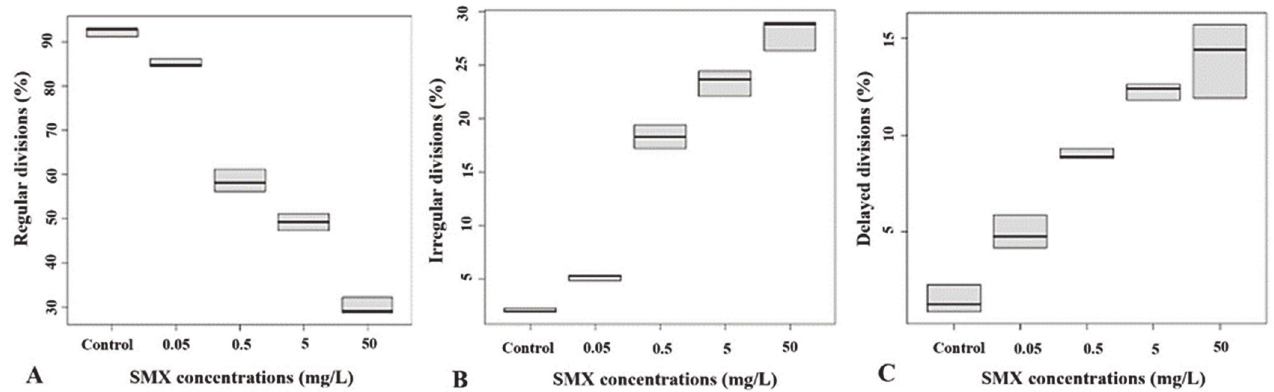
Figure 3. Percentage of embryos’ regular ( A ), irregular ( B ), and delayed divisions ( C ) at 2 h post- fertilization after incubation with sulfamethoxazole solutions (SMX) considering division stages with a number of blastomeres ≥ 16.